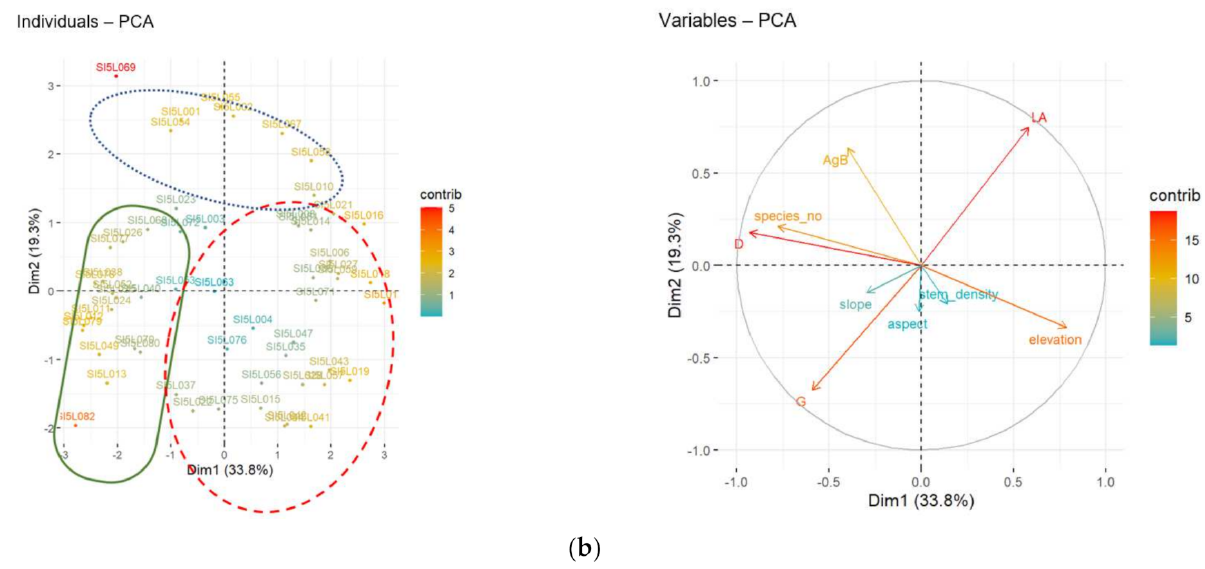
Figure 3. Principal components analysis of abiotic, tree and stand variables applied to: ( a ) all plots; ( b ) plots from the first level of PRP (Abbreviations: DIM = Dimension; contrib = variable or plot contribution in terms of variance explained).